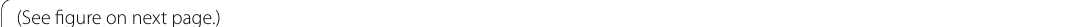
Fig. 1 The other-race effect in the memory task. A , B Scatterplots (with best-fitting regression lines) showing the relationship between the ORE with face recognition ability, experience, and implicit bias, in ∆d’ and ∆RT. C Mean other-race effect (∆d’ and ∆RT) as a function of 1 SD above and below the means of the measures of implicit racial bias (IAT) and face recognition ability (CFMT). The ORE in ∆d’ was predicted by experience, implicit racial bias, and the interaction between implicit racial bias and face recognition ability. For ∆RT, neither the regression model, nor any of the predictors,